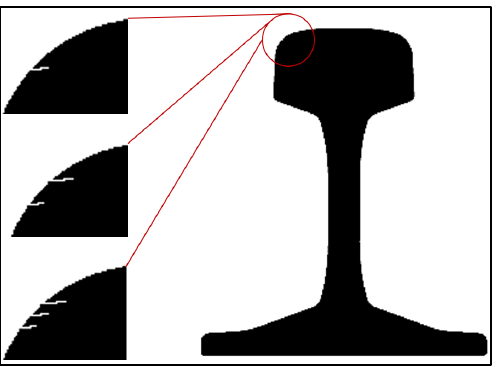
( b ) Figure 5. ( a ) Leap-frog time integration of the elastodynamic equations. ( b ) Spatial grid by stagger- ing stress tensor 𝜎 (cid:3036)(cid:3037) and velocity vector components 𝑣 (cid:3036) (reprinted from [13]). The software implementation was undertaken in Python using TensorFlow [14] as a tool for a convenient parallelization, enabling computation on multiple CPUs combined with GPU. The computations shown in this work, i.e., a 2D model of the rail cross-section, were performed using an Intel Xeon CPU E5-1650 v4 @ 3.60 GHz workstation with 6 cores and 30 GB RAM with a typical calculation and postprocessing time of ~22 h. The rail geometries were drawn with the CAD package DraftSight and imported as a regular 2D cartesian grid with square edge length of 0.15 mm (i.e., a resolution of 20 grid points per wavelength) into the EFIT software. The values for the material parameters are listed in Table 1. The initial conditions were a zero stress and velocity field in the whole domain. The excitation was implemented by setting a time-dependent velocity boundary condition at the location of the sending transducer—left bottom of the rail head (position HBL)—cor- responding to the contact of the transducer comb (sender) with the rail body. The time dependence of the input signal was determined to match the waveform found experimen- tally. Three different crack constellations with 1–3 cracks, as shown in Figure 6, were used in the simulations. The geometry parameters of the investigated crack configurations were